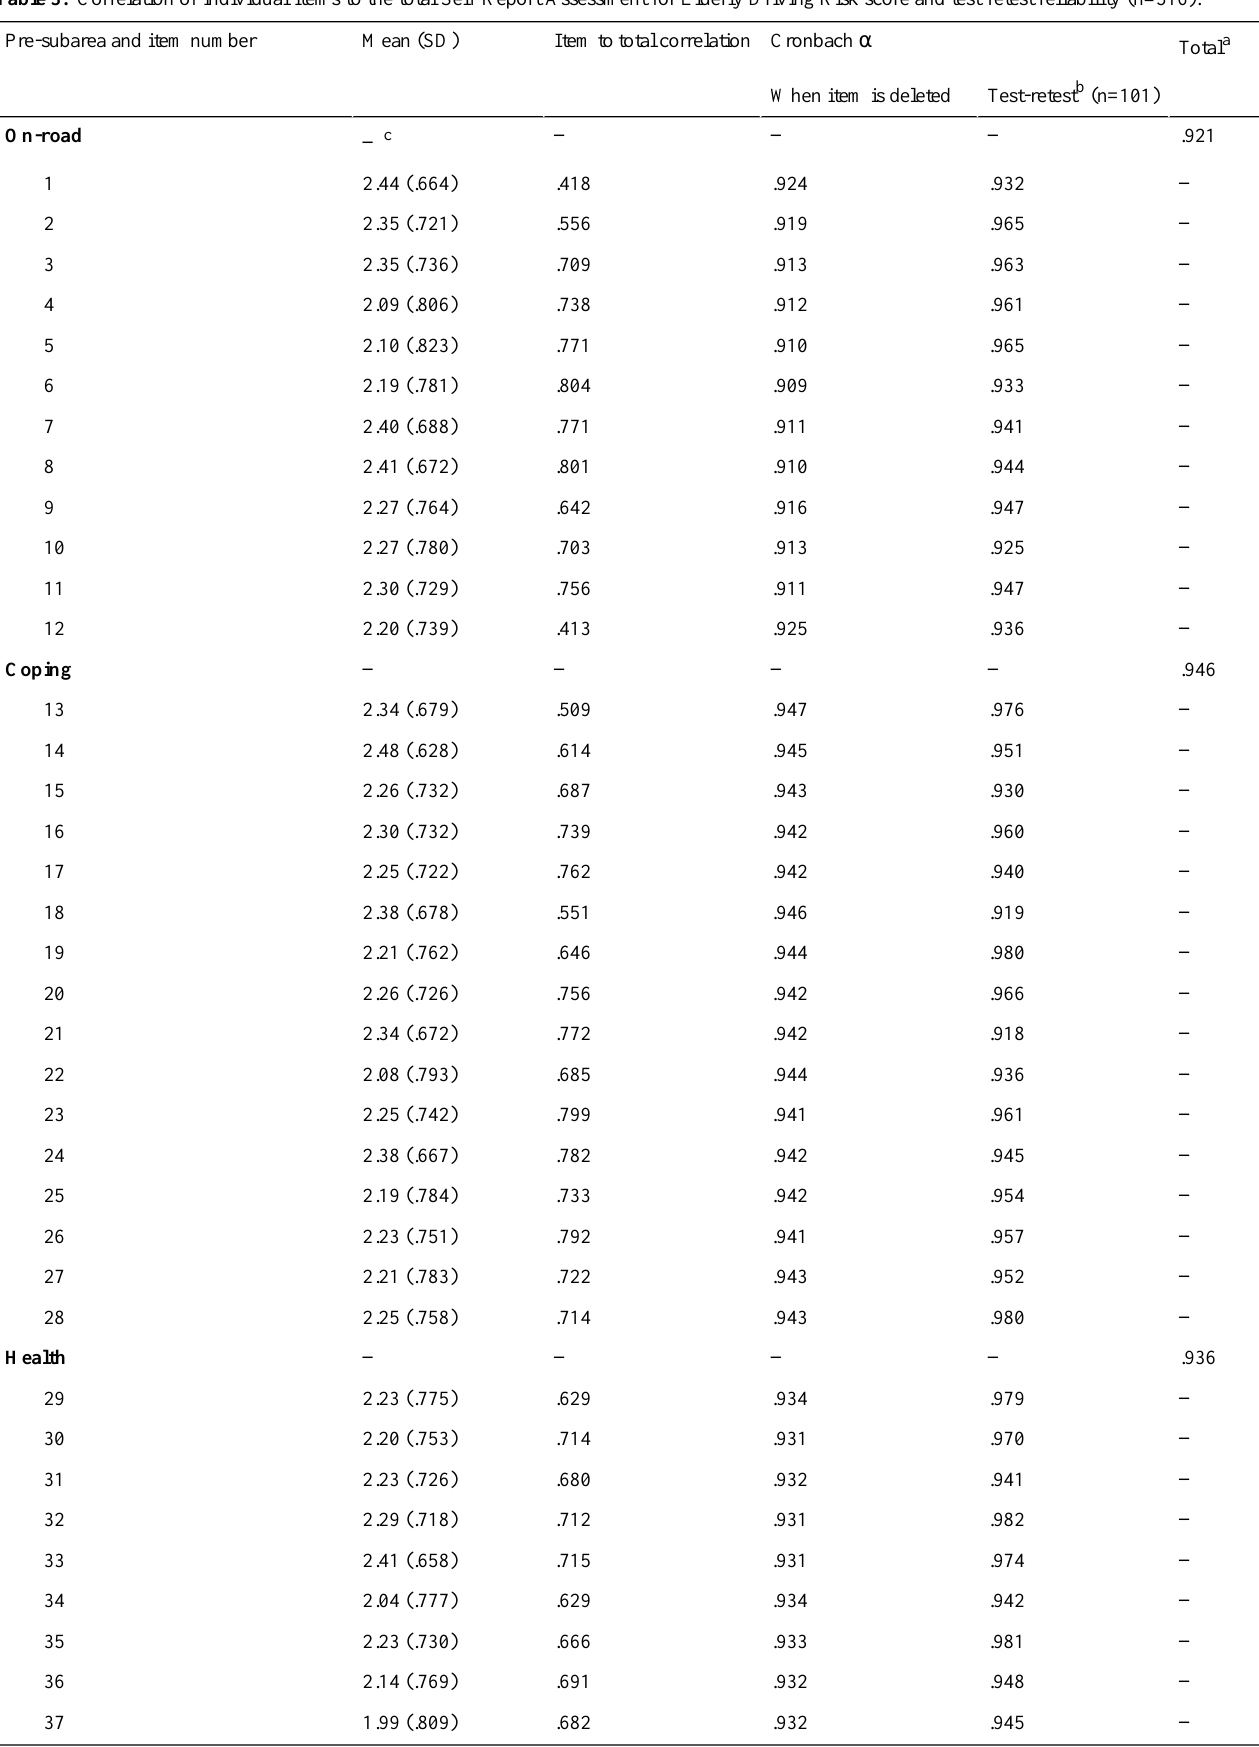
Table 3. Correlation of individual items to the total Self-Report Assessment for Elderly Driving Risk score and test-retest reliability